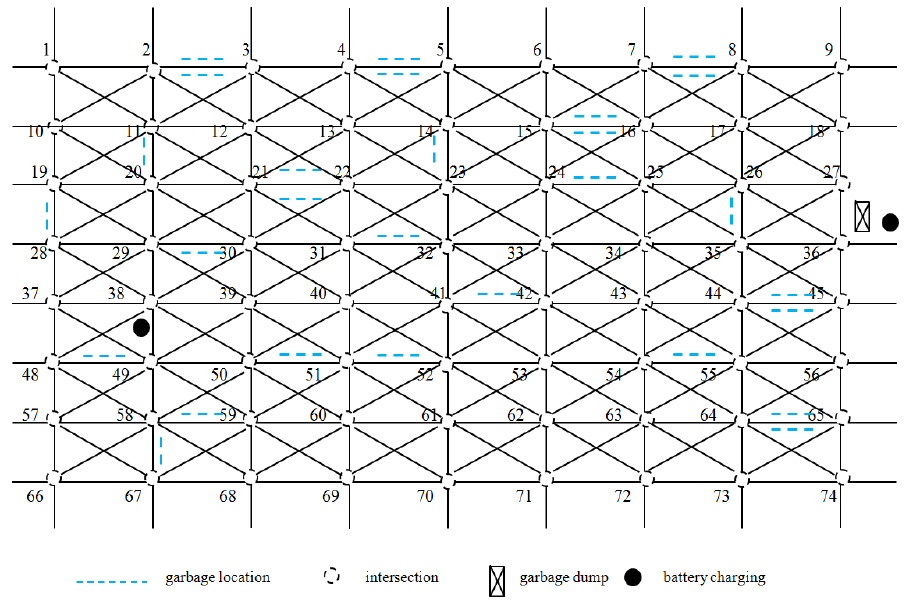
Figure 4. Transportation network for municipal waste collection.